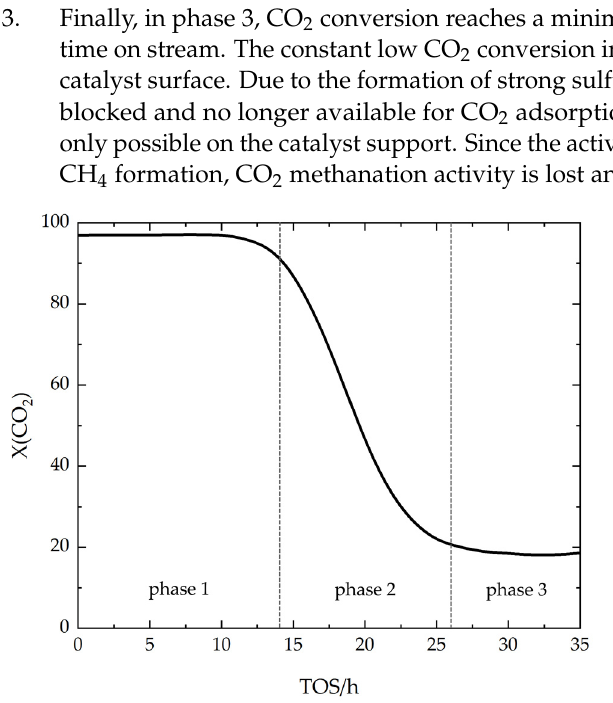
Figure 4. CO 2 conversion course during H 2 S poisoning of arbitrary catalyst with division into three distinct phases.